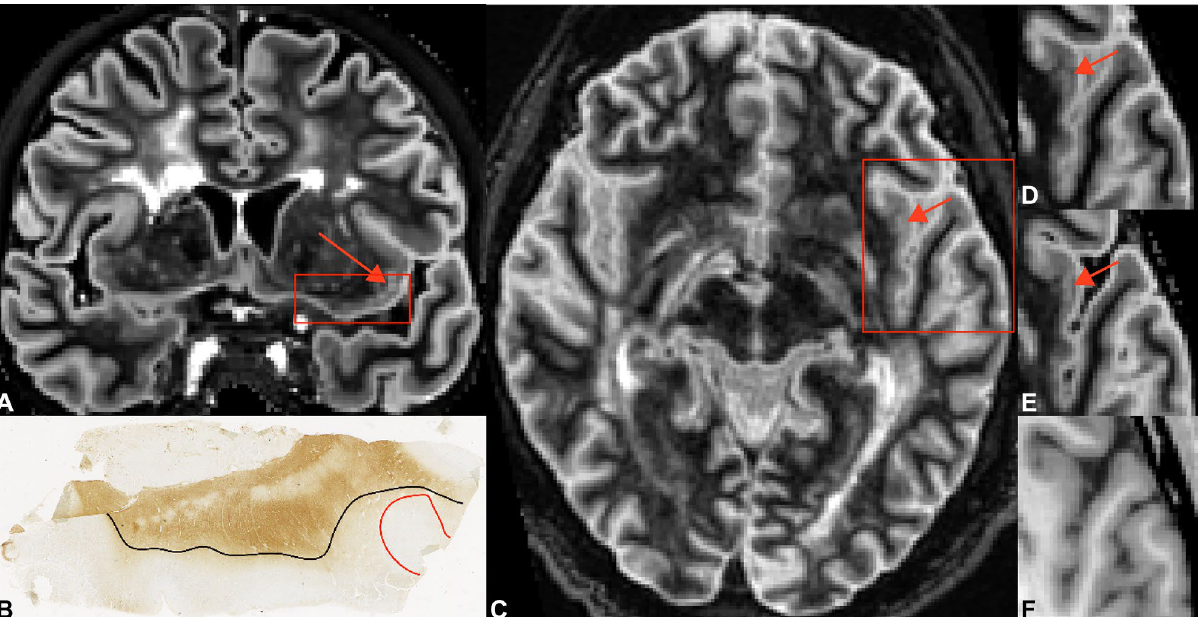
Figure 1. Example of a type IV cortical lesion in the insular cortex, that is a priori visible on both artificially generated and conventionally acquired DIR images but not on standard 3D-T 1 . ( A ) Coronal slice in which the histopathological sample is indicated by the rectangle; the arrow indicates a visible type IV lesion. ( B ) Histopathological tissue sample with the type IV lesion indicated by the red line and the cortex by the black line. ( C ) Conventionally acquired DIR image with the type IV lesion indicated by the arrow; the rectangle demarcates the inset that is being shown in images D-F. ( D ) Inset of the corresponding artificial DIR image generated from 3D-T 1 and 3D-FLAIR with the type IV lesion indicated by the arrow. ( E ) Inset of the corresponding artificial DIR image generated from 3D-T 1 and PD/T 2 , with the type IV lesion indicated by the arrow. ( F ) Inset of the corresponding standard 3D-T 1 image, in which the type IV lesion is not visible (generated using Adobe Illustrator—Adobe Inc., 2019. Adobe Illustrator, Available at https:// adobe. com/ produ cts/ illus